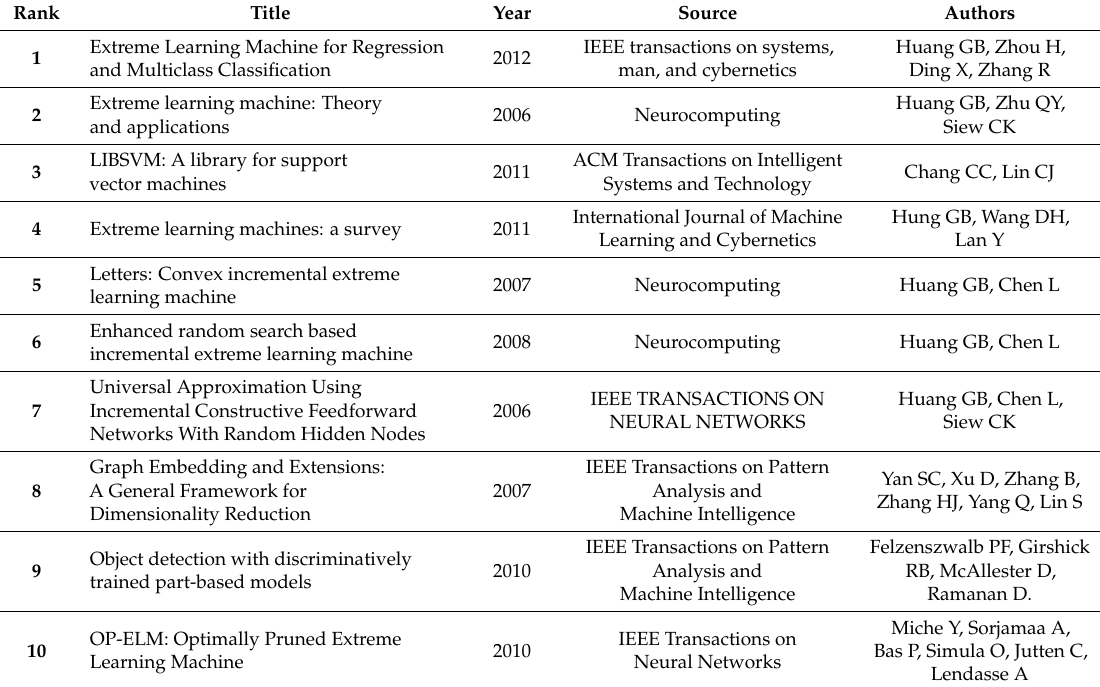
Table 6. Top 10 Highly Cited References in